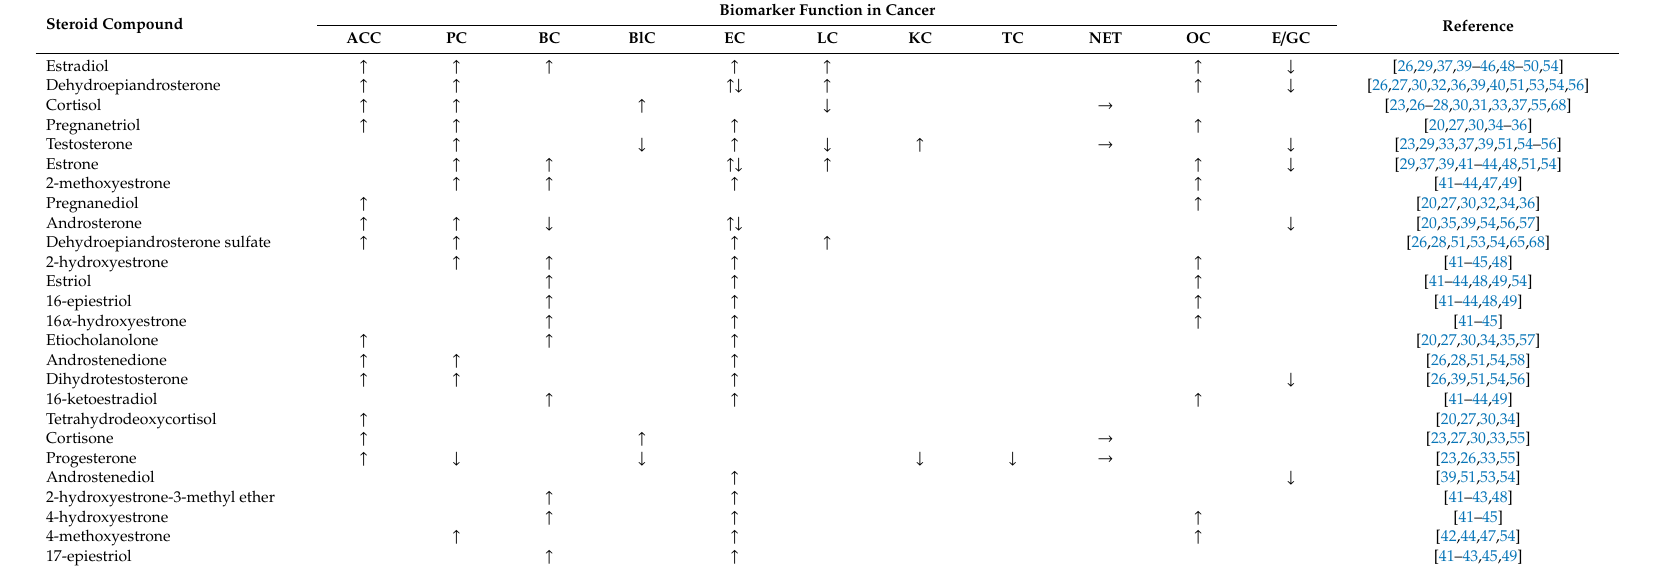
Table 2. Potential steroid biomarkers * reported in at least four